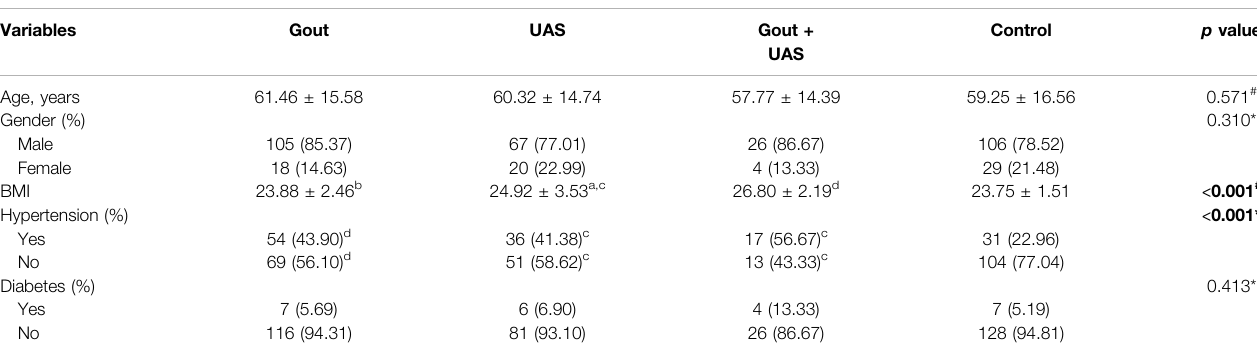
TABLE 1 | Comparison of general characteristics between each group.